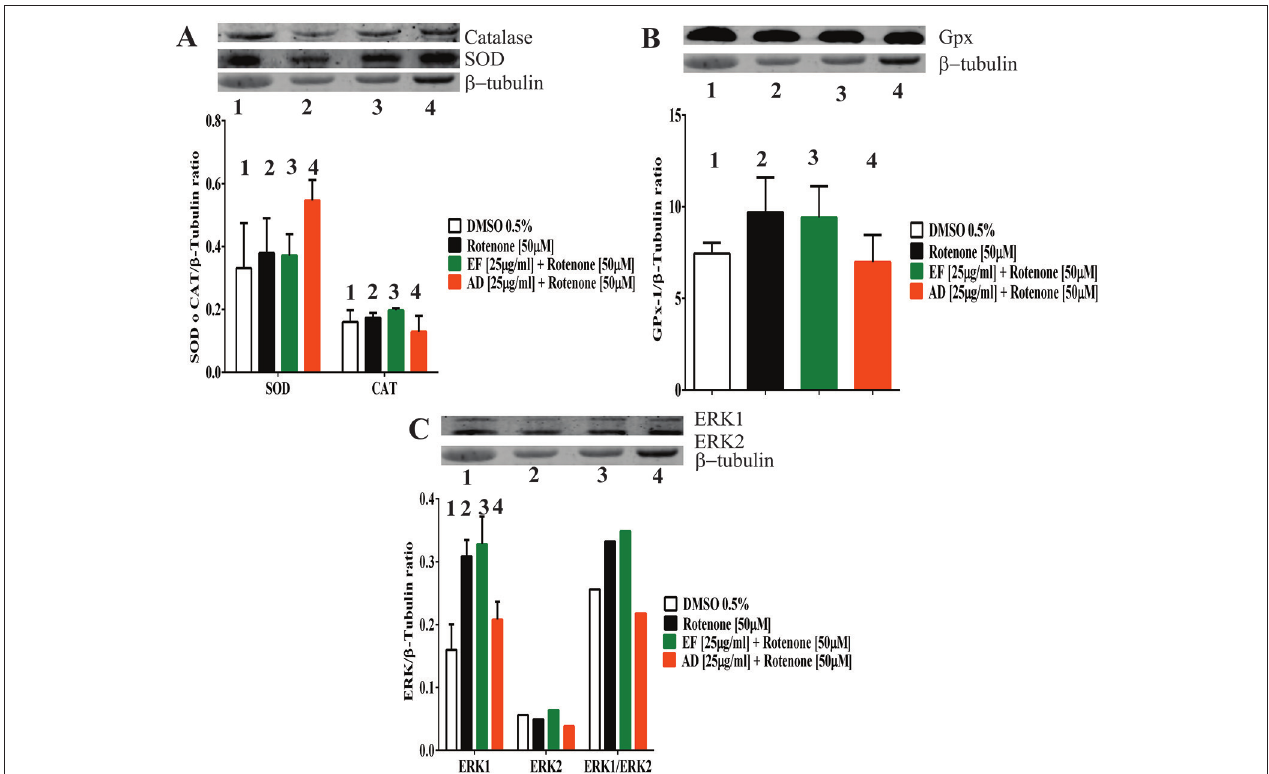
FIGURE 4 | Expression of antioxidant defense and ERK proteins in T98G cells. (A) Expression of Superoxide dismutase (SOD) and Catalase determined by Western Blot in T98G cell cultures after co-treatment with 50 µ M rotenone plus EF and AD at 25 µ g/ml. (B) Expression of Glutathione determined by Western Blot in T98G cell cultures after co-treatment with 50 µ M rotenone plus EF and AD at 25 µ g/ml. (C) Expression of ERK and MAPK proteins determined by Western blotting on T98G cells after co-treatment with rotenone plus EF and AD at 25 µ